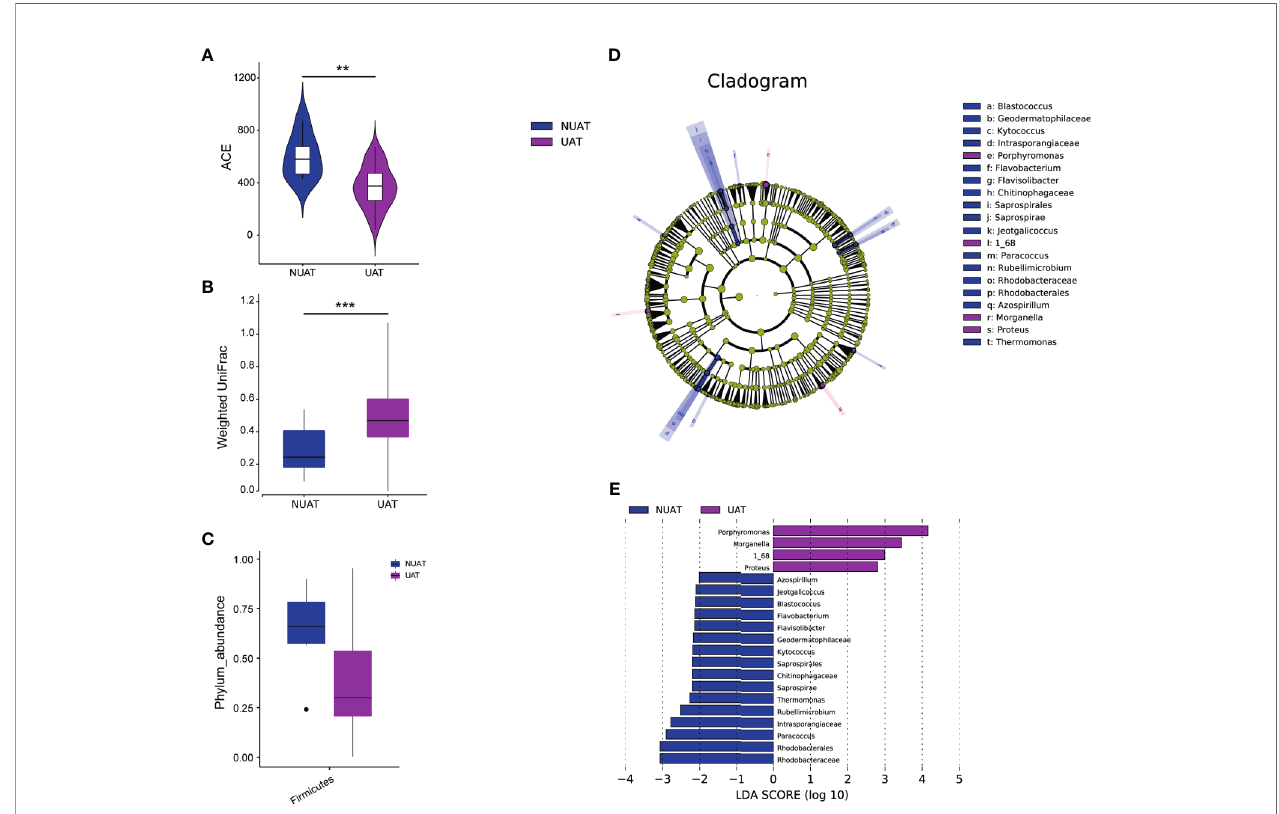
FIGURE 3 | Unique nasal microbiota pro fi les in patients with NUAT-NKTCL. Comparison of the nasal microbial (A) alpha diversity (ACE index), P = 0.00323, Wilcoxon test, and (B) beta diversity, P < 0.001, weighted UniFrac index, between the NUAT and UAT groups. (C) The abundance of the phylum Firmicutes was signi fi cantly increased in the NUAT (n = 6) versus UAT (n = 40) patients ( P = 0.0415). LEfSe for the nasal microbiota in the NUAT and UAT groups. (D) The cladogram shows differences in microbial taxa between NUAT and UAT patients. Letters refer to differentially abundant taxa. (E) The histogram represents linear discriminant analysis (LDA) scores of bacteria with signi fi cantly different abundances (LDA > 2) between the two groups, as represented by different colors. The taxa with LDA > 2 are shown. NUAT, non-upper aerodigestive tract; UAT, upper aerodigestive tract; LDA, linear discriminant analysis; LEfSe, LDA effect size; ** P < 0.01, *** P <